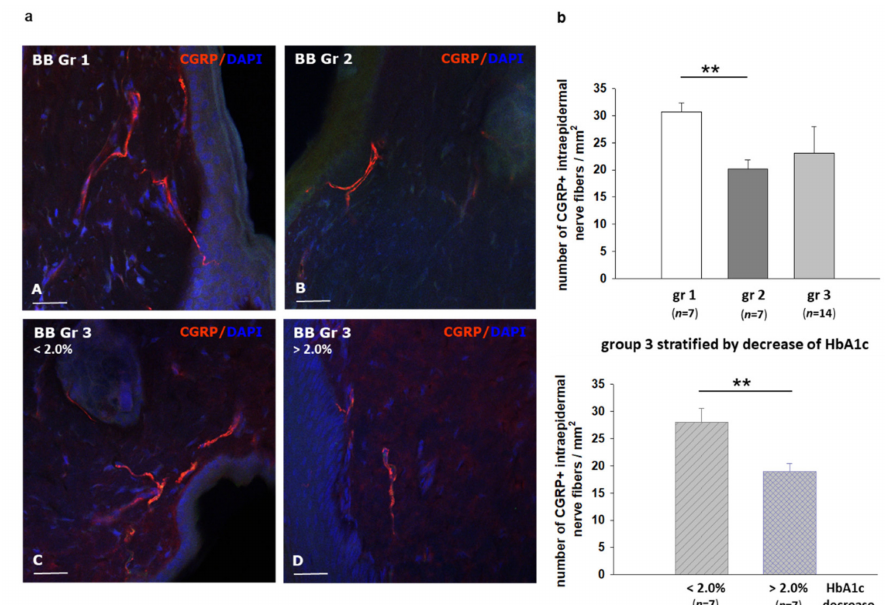
Figure 7. Sensory nerve endings in the skin of the hind foot in BB/OKL rats at the end of month 3. ( a ) Immunofluorescence staining for calcitonin gene related peptide ( CGRP ) protein (red, A-D). Nuclei are counterstained with DAPI (4 (cid:48) ,6-diamidino- 2-phenylindol, blue). ( b ) Quantification of CGRP —positive IENFDs (intraepidermal nerve fiber density) in group 3 separated by the reduction in HbA1c values. A marked reduction in CGRP expression was noted in subgroup 3 with a reduction in HbA1c values >2%. Data from n = 7 are presented as mean ± SEM. ** p ≤ 0.01 according to the one-way analysis of variance together with the Newman–Keuls test. A-D: Bars represent 15 µ